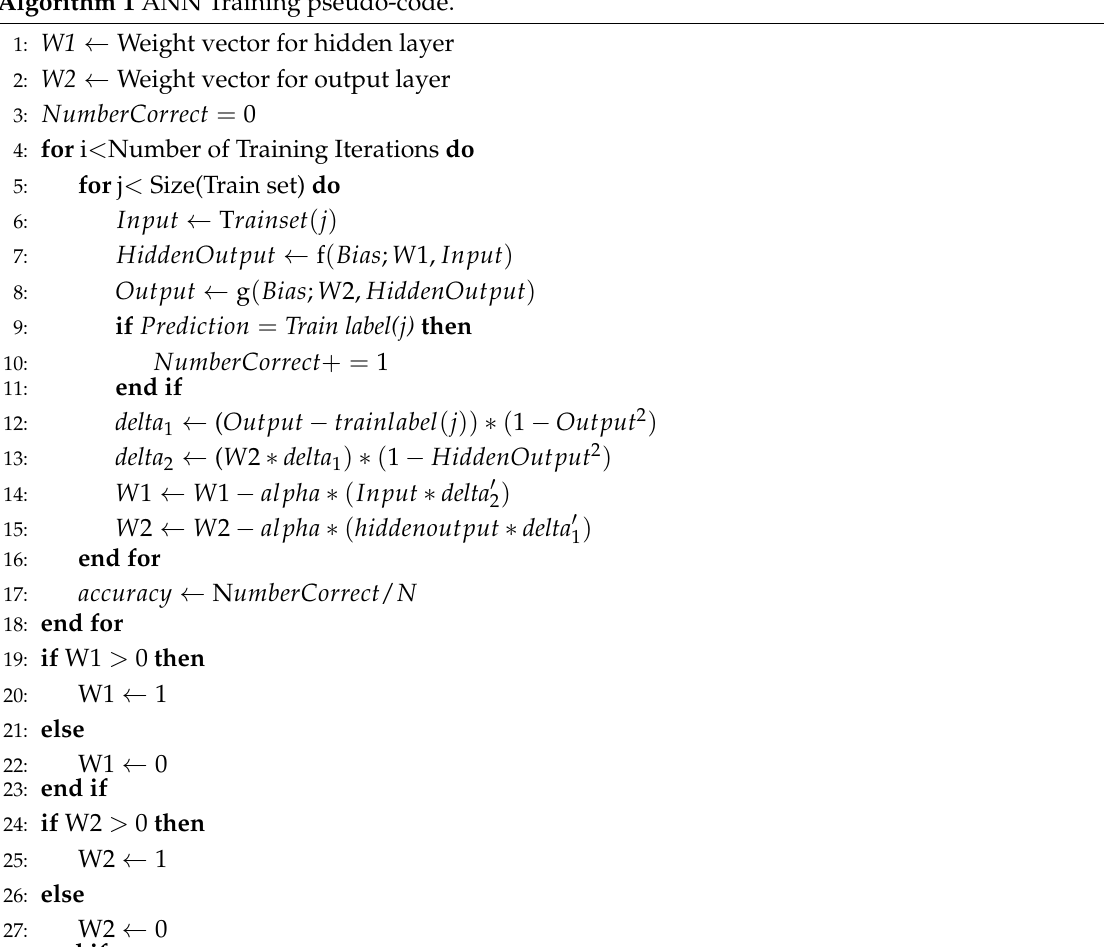
Algorithm 1 ANN Training